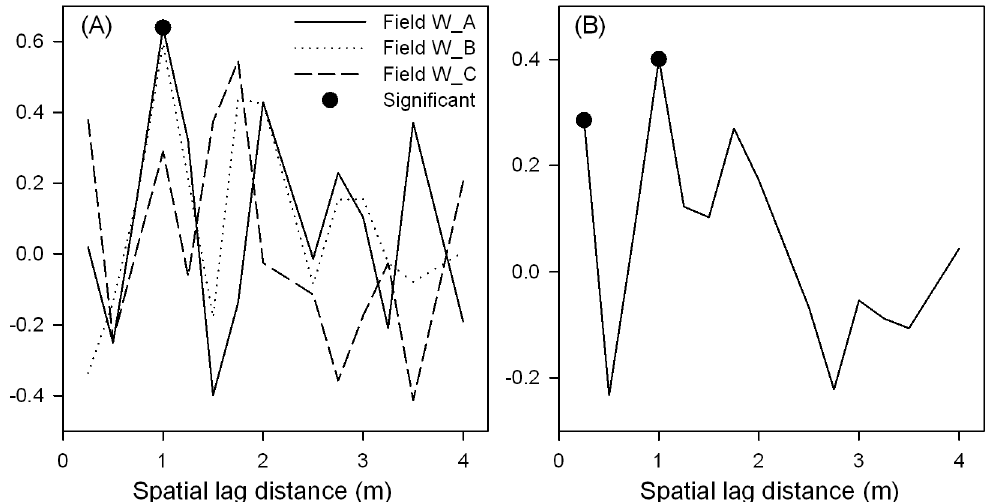
Fig 4. Spatial autocorrelation of inoculum density of Verticillium dahliae from point sampling. (A) individual fields, and (B) pooled over three fields. Within each field, 70 samples were collected by point sampling (at depth 0 – 20